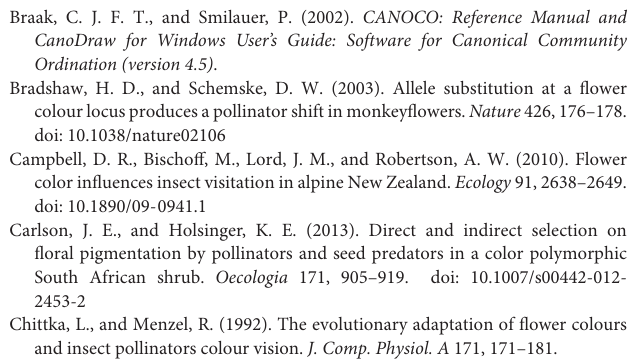
Supplementary Table 5a | Total variance of explained soil variable components. Supplementary Table 5b | Component matrix for G. aurantiaca soil variables. Supplementary Table 5c | Regression factor scores for soils PCA of 14 G. aurantiaca